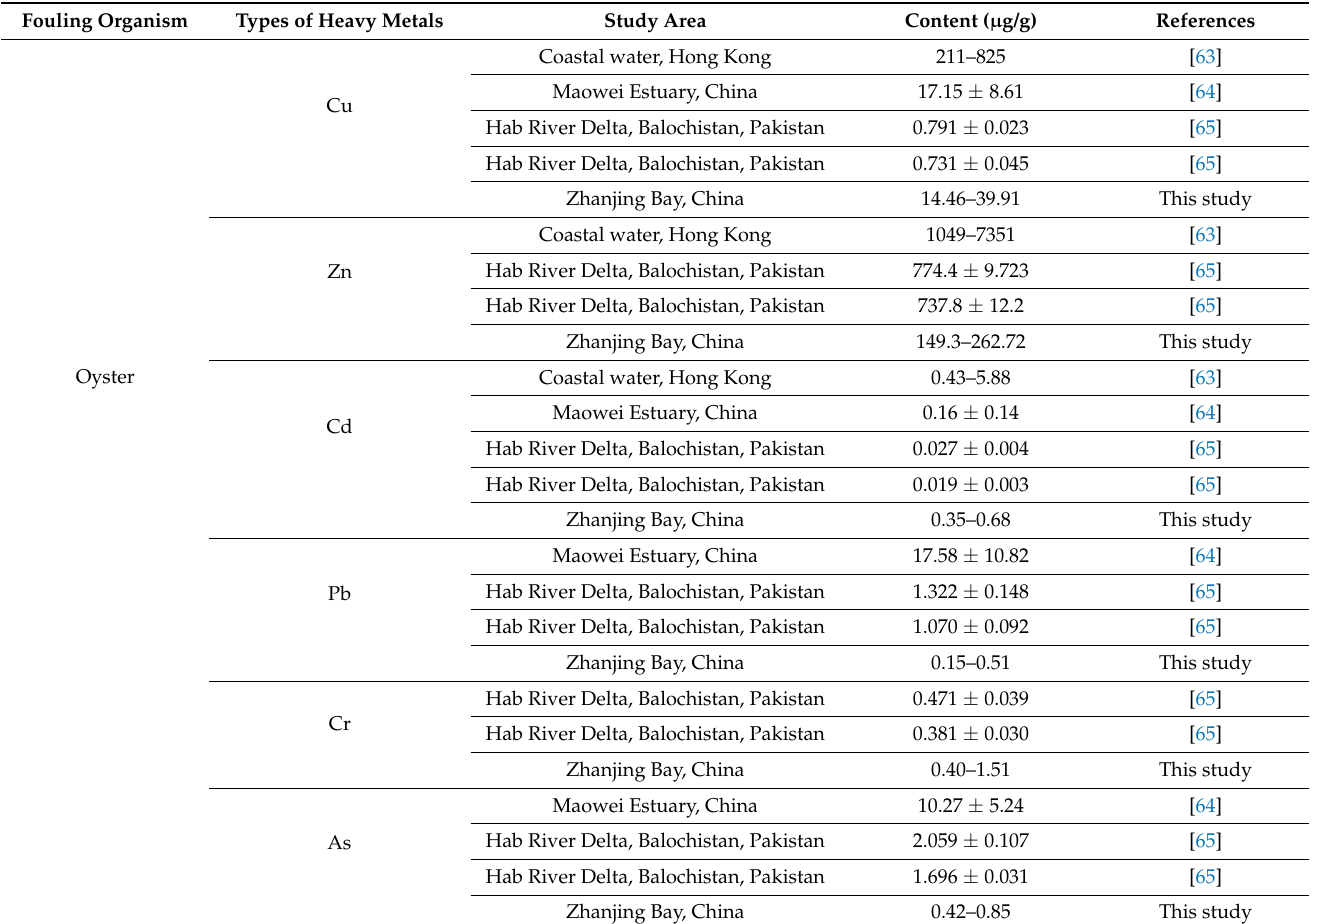
Table 6. Comparison of heavy metals Cu, Zn, Cd, Pb, Cr and As in oysters and barnacles worldwide (dry